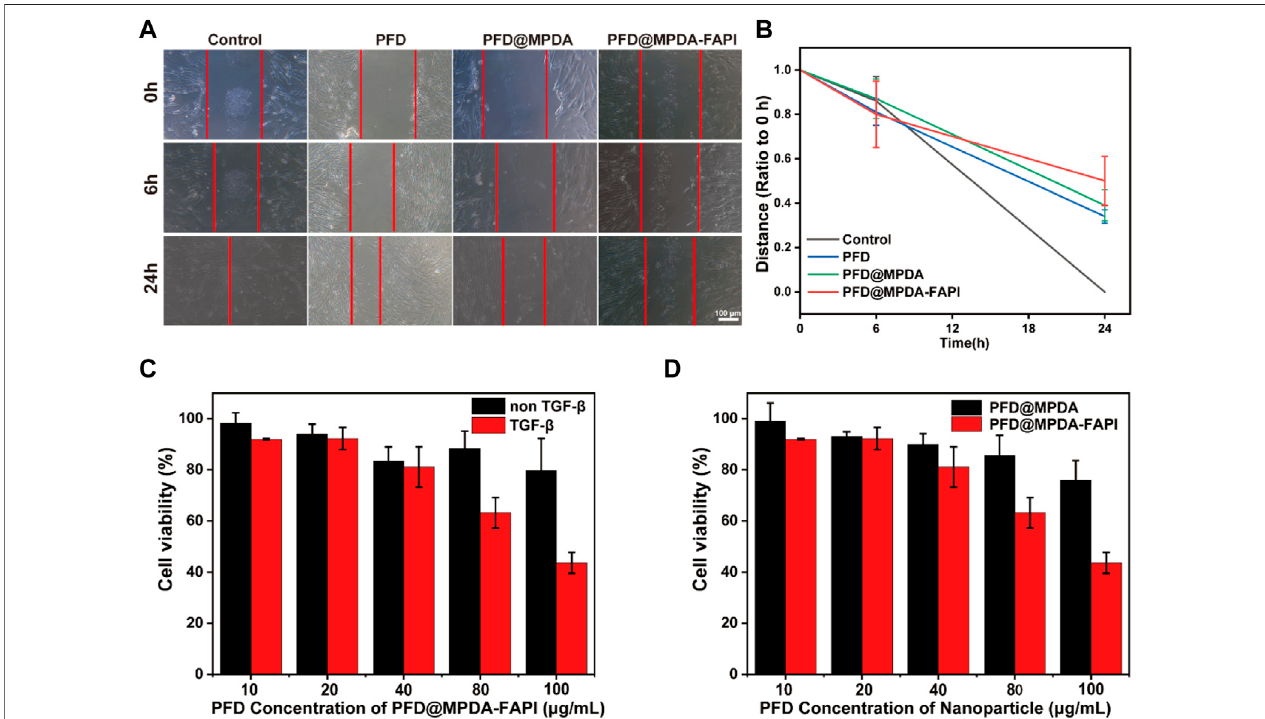
FIGURE 4 | (A,B) Scratch test results of HFL1-1 treated by TGF- β and incubated with PFD, PFD@MPDA, and PFD@MPDA-FAPI. (C) Proliferation test of PFD@ MPDA-FAPI NPSs after incubation with HFL1 cells without/with TGF- β for 24 h. (D) Proliferation test of PFD@MPDA and PFD@MPDA-FAPI NPSs after incubation with HFL1-1 cells treated by TGF- β for 24 h (** p <